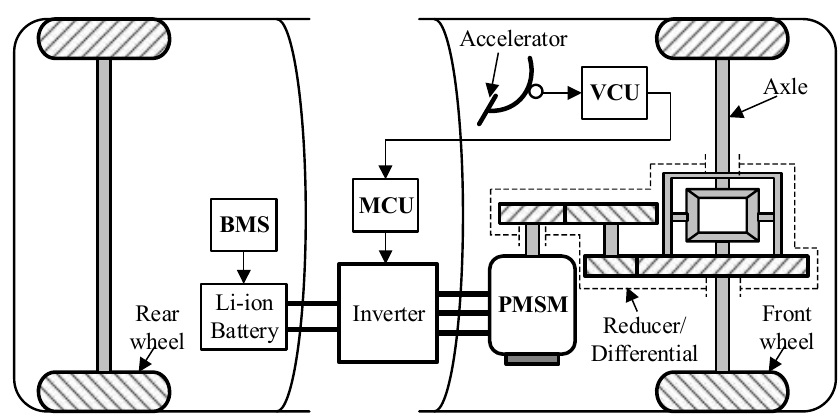
Figure 19. Configuration of the driveline of an electric vehicle (EV) (BMS: Battery Management System; MCU: Motor Control Unit; VCU: Vehicle Control Unit).